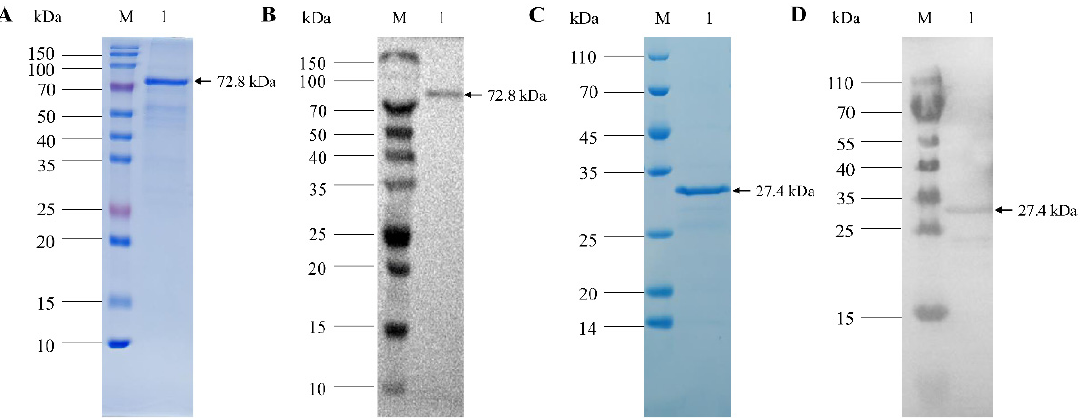
Figure 1. Purification and Western blot analysis of CIAV recombinant VP1 and VP2 proteins. ( A ): SDS-PAGE of purified recombinant CIAV VP1 protein. ( B ): Western blot analysis of CIAV VP1 protein using anti-VP1 monoclonal antibody. ( C ): SDS-PAGE of purified recombinant CIAV VP2 protein. ( D ): Western blot analysis of CIAV VP2 protein using anti-VP2 polyclonal antibody.